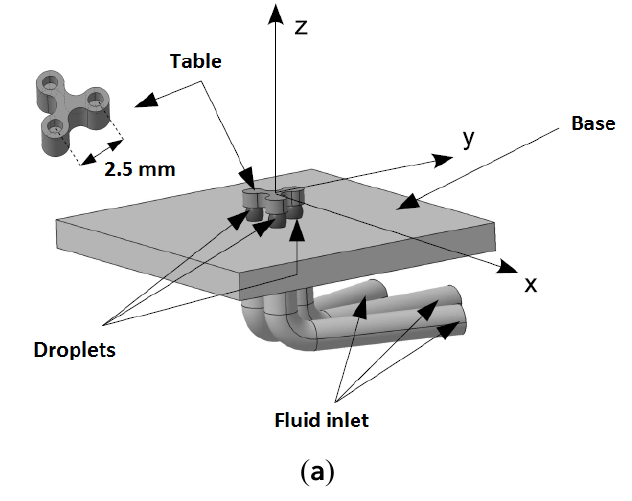
Figure 1. ( a ) General views and principle: The three fluid income pipes control the pressure in the three droplets, acting as z-actuators able to modify the z position and the Θ tilts; ( b ) Scale comparison: The pitch between to droplets seats is 2.5 mm; ( c ) water droplets supporting the platform manufactured by additive manufacturing (Courtesy Marc